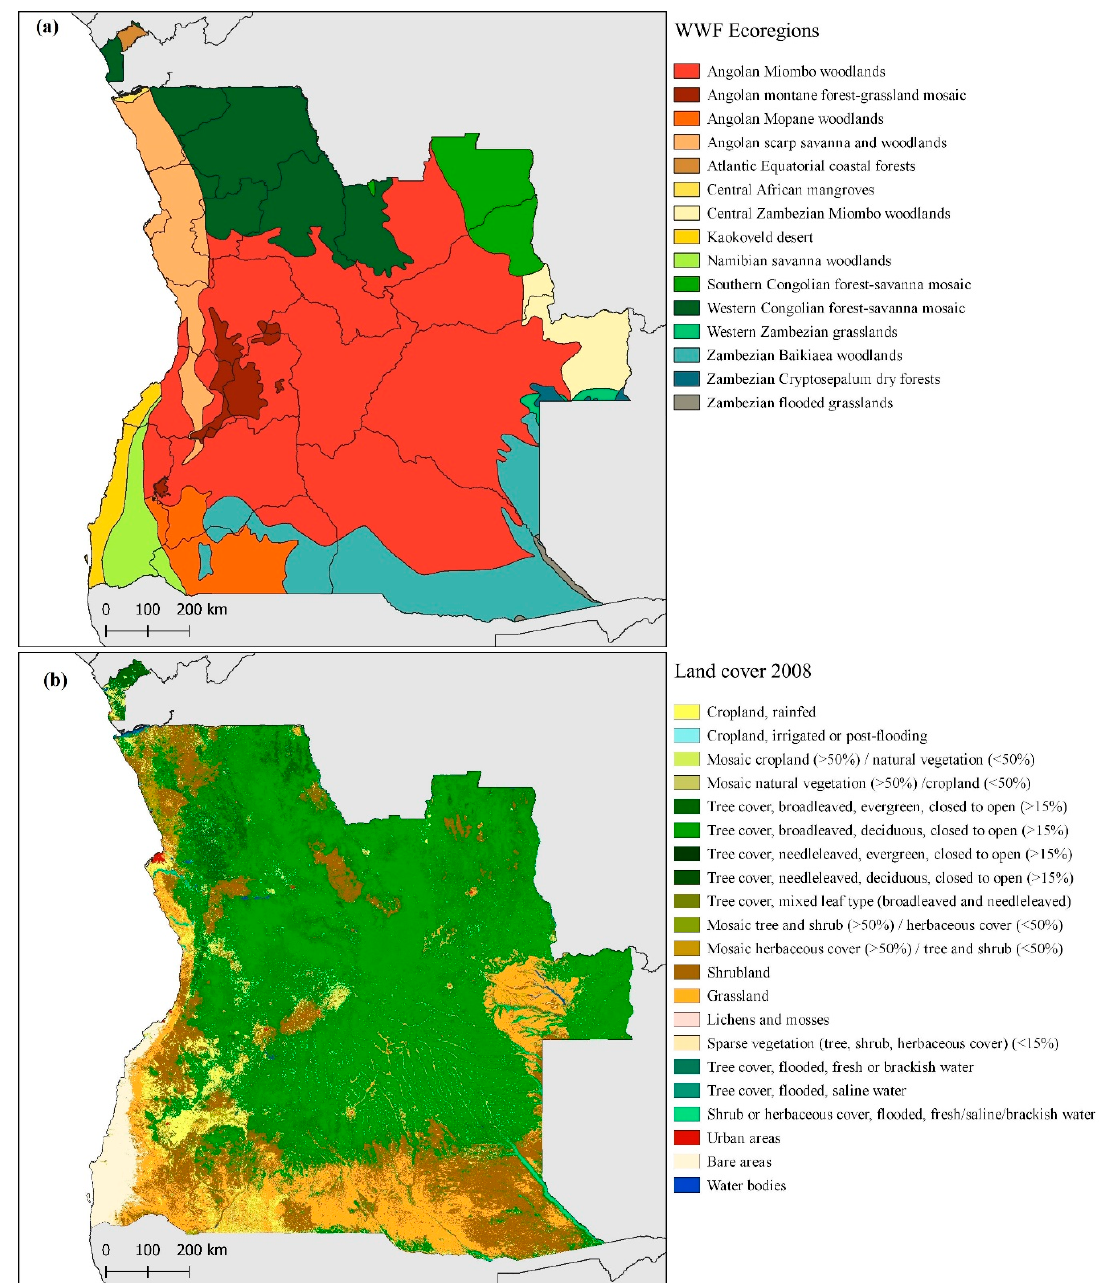
Figure 2. World Wildlife Fund (WWF) ecoregions and land cover map of Angola: ( a ) WWF ecoregions occurring in Angola [20]. The black lines represent the boundaries of the 18 provinces of Angola; ( b ) land cover map of Angola in 2018 (300 m resolution) adapted the European Space Agency (ESA) Climate Change Initiative Land Cover (CCI-LC) project [70].